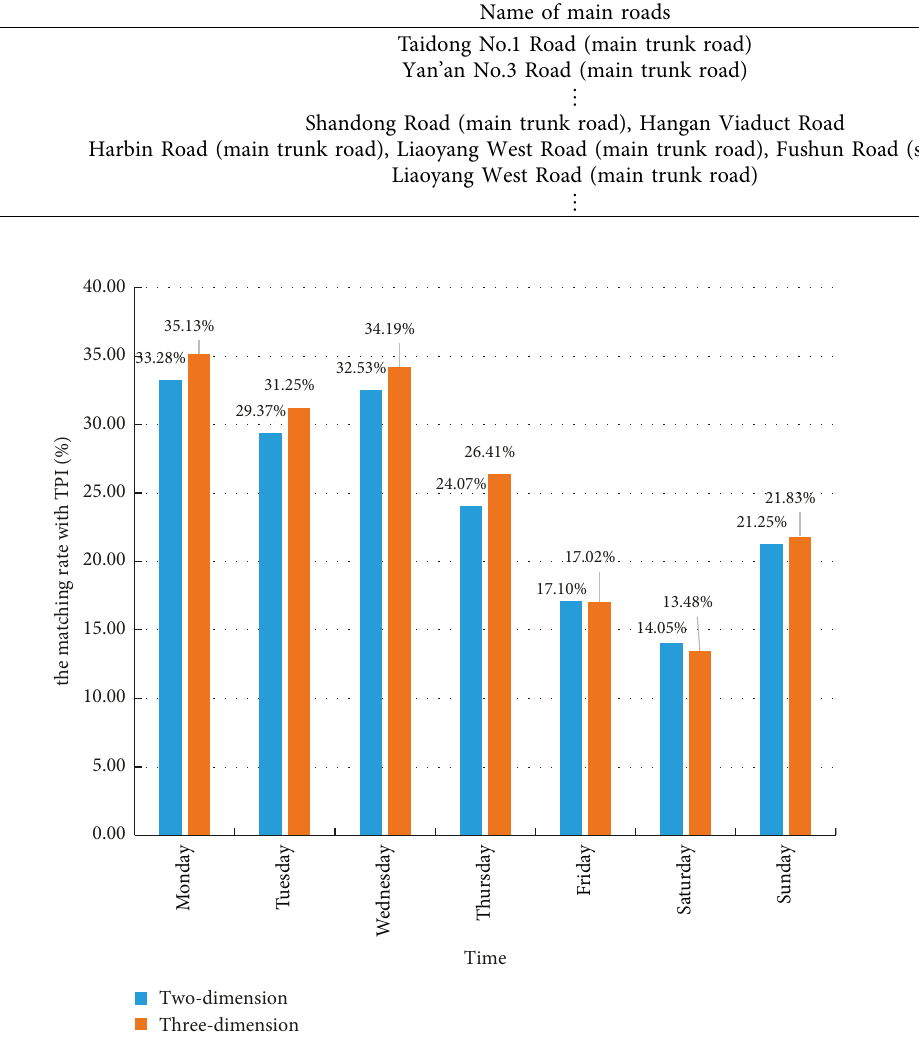
Figure 12: The matching rate of the identified result and TPI.